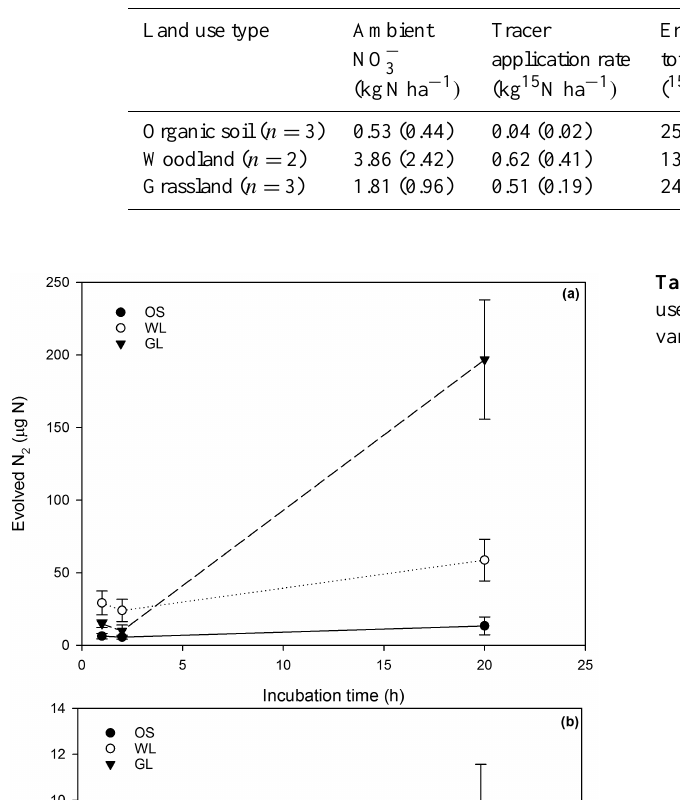
Table 2. The ambient soil nitrate pool, the 15 N tracer application rate, the estimated enrichment of the total soil nitrate pool, the calculated 15 X 15 X N value from N 2 O, and the slope of the N change with incubation time in the three land use types. Data are means with standard errors in parentheses.